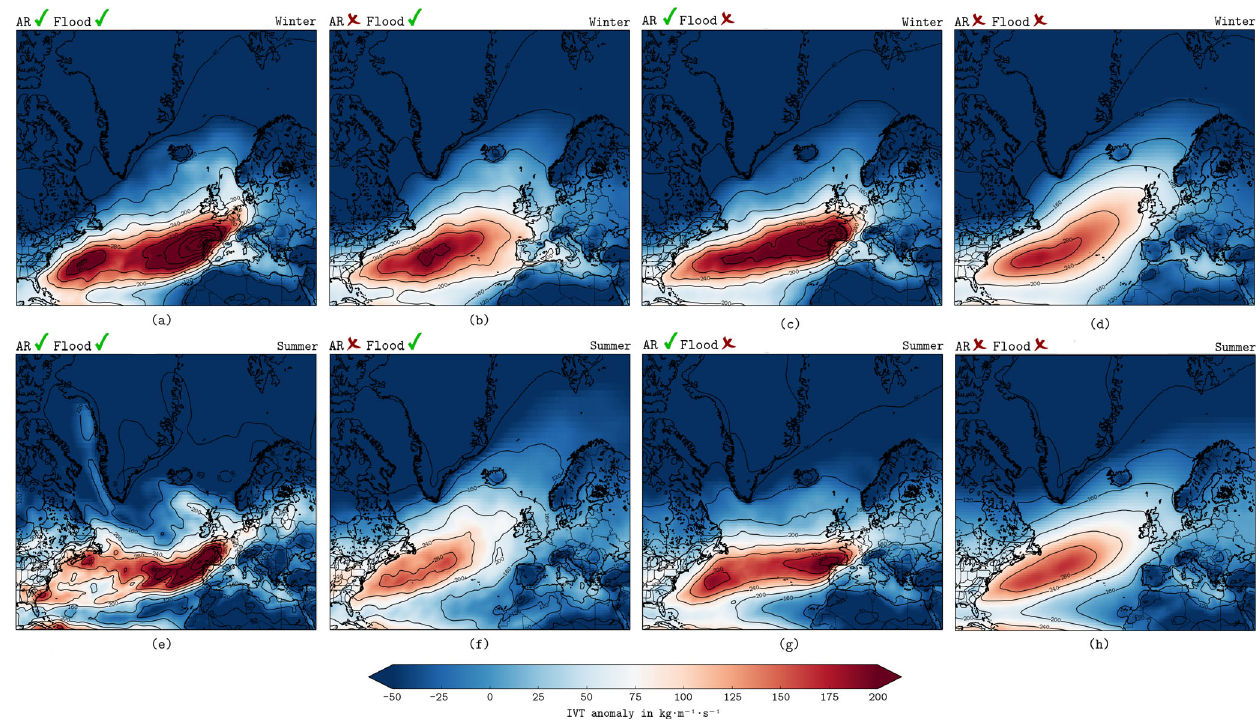
Figure 7. Same as Fig. 6 but with IVT